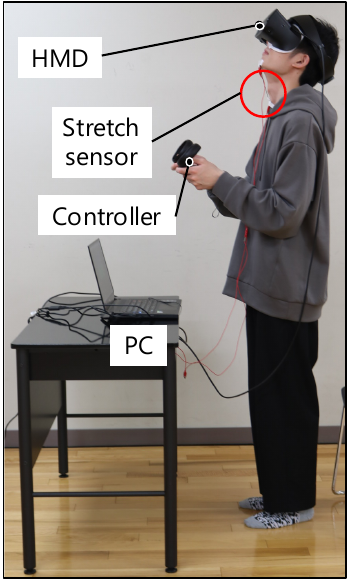
Figure 11. The setup of the experiment.